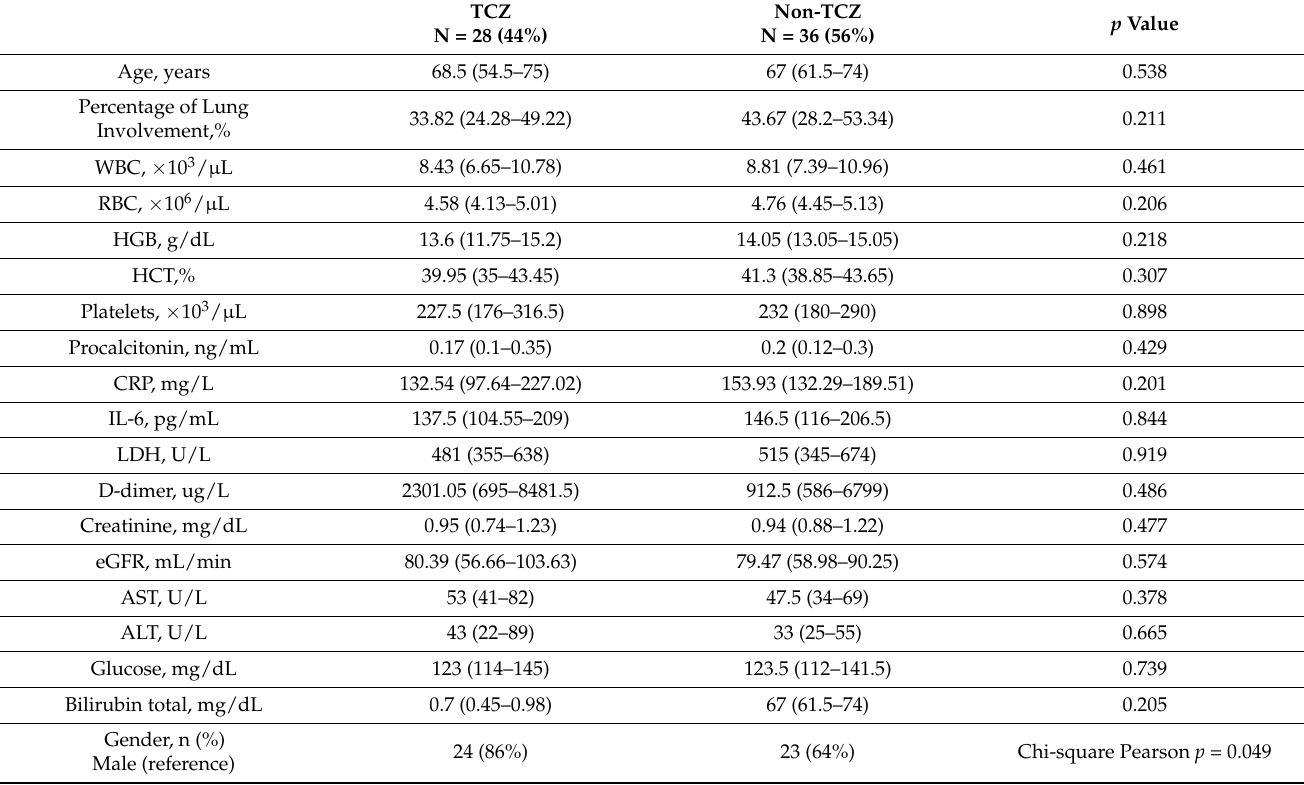
Table 2. Characteristic of Groups TCZ vs.